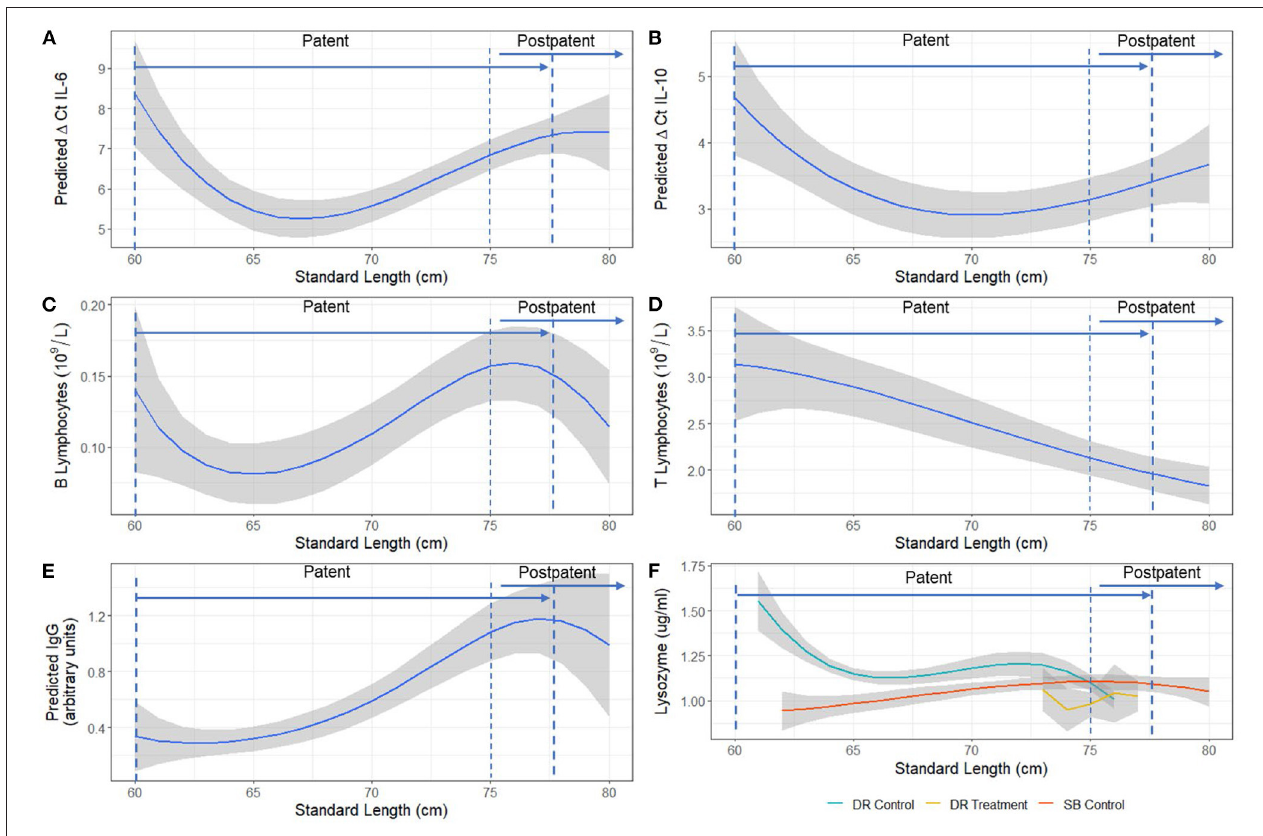
FIGURE 2 | Model estimated relationship between (A) 1 Ct IL-6, (B) 1 Ct IL-10, (C) B lymphocytes, (D) T lymphocytes, (E) IgG, and (F) Lysozyme and standard length (cm) of Australian sea lion ( N. cinerea ) pups. Statistical models for T and B lymphocyte populations and IgG were performed on a log scale, but model-derived back-transformed means (emmeans package R) are presented. The shaded area represents the 95% confidence interval. Lower 1 Ct indicates greater cytokine expression. Patency periods adapted from Marcus et al.